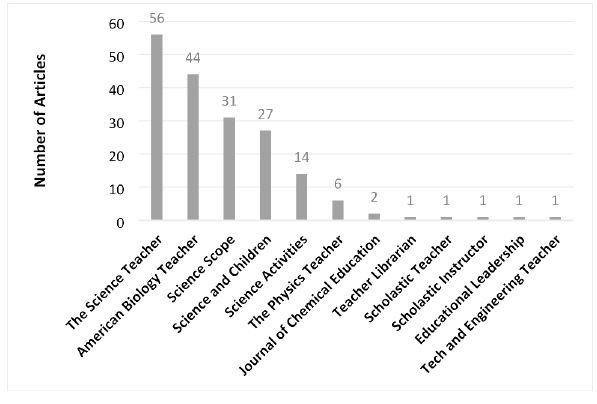
Fig. 1 Number of Articles Analyzed by Journal Title (n =